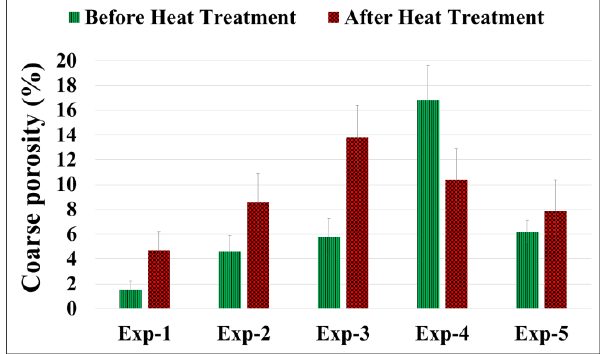
Figure 4. Coarse porosity content in % area for all coatings before and after heat treatment.